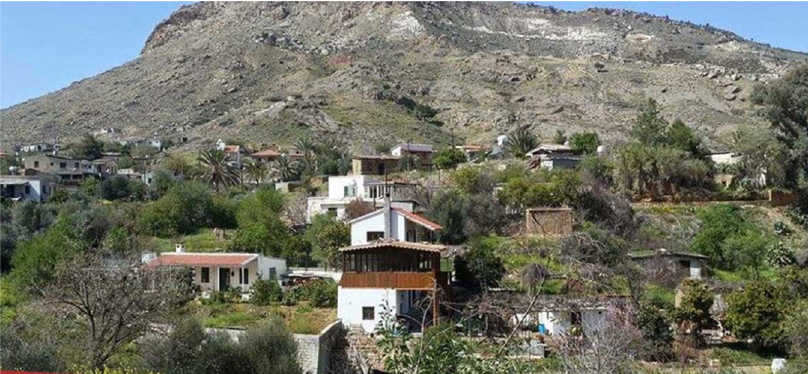
Fig. 5 Komikebir village. Komikebir general appearance.